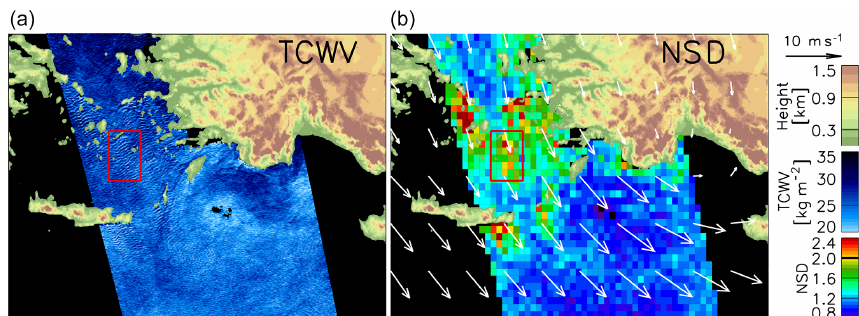
Figure 2. (a) AIRWAVE TCWV for 2 August 2002 and AATSR orbit 2214 (ascending). (b) Corresponding normalised standard deviation. The arrows represent the wind speed (length) and direction, as derived from ERA-Interim products at 1 . 0 ◦ × 1 . 0 ◦ resolution. The area delimited by the red box is studied more in detail in Fig. 4.